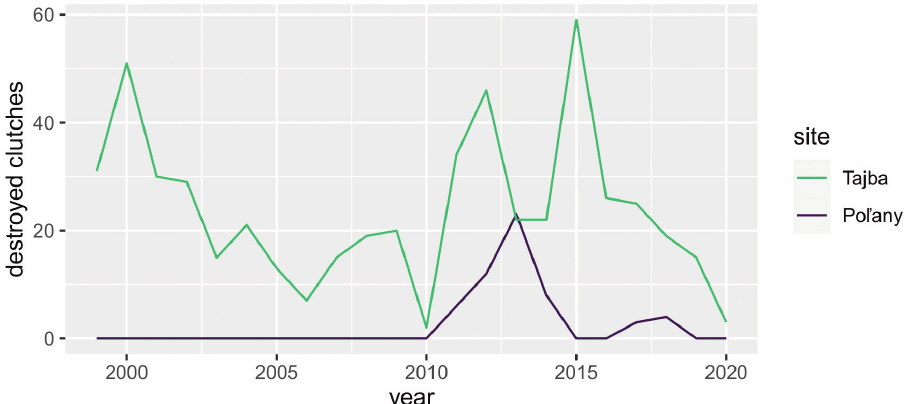
Figure 3. Plot of destroyed clutches found at the nesting sites in the Tajba NNR and in Poľany during the period